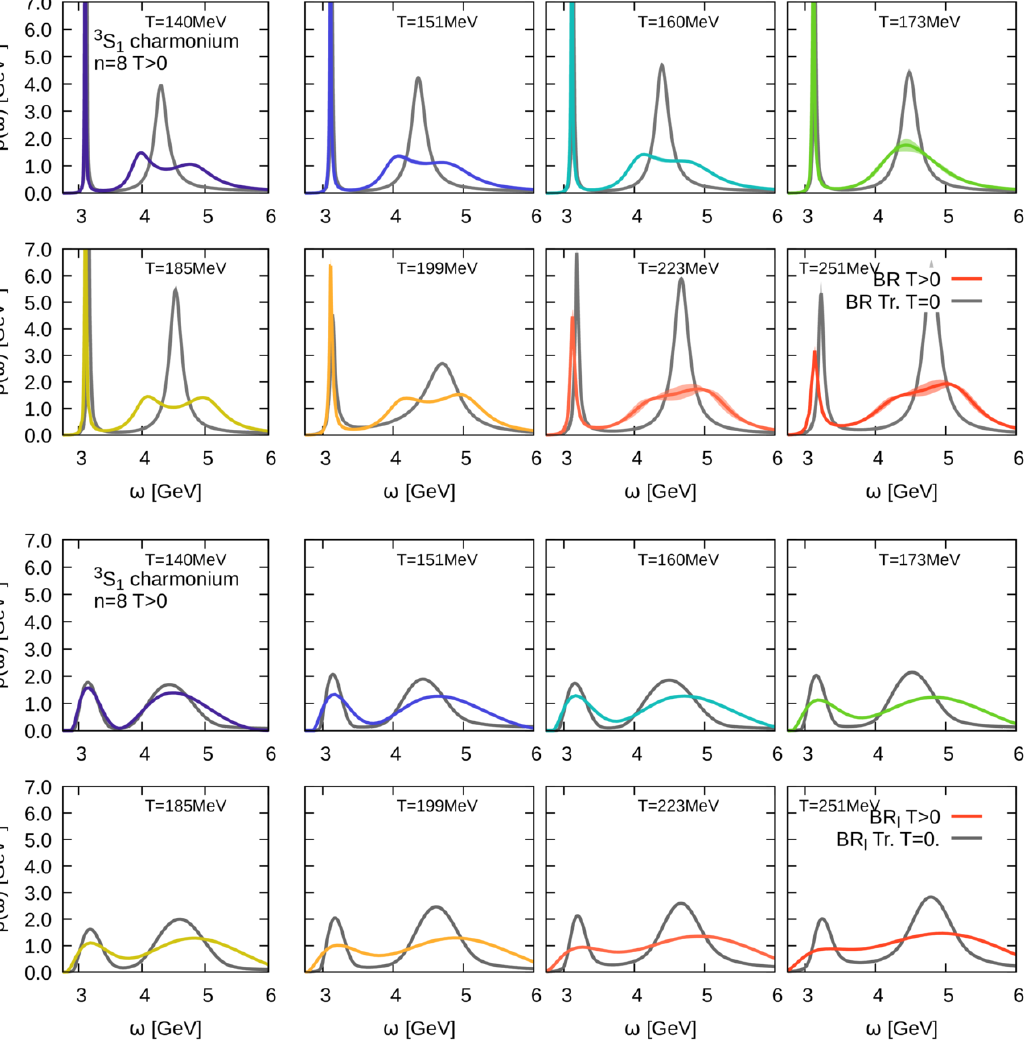
Figure 42 . Comparison of the (top) BR truncated at T = 0 and at T > 0 (bottom) the same comparison for the smooth BR method in the 3 S 1 charmonium channel. Here we have the same statistics at T = 0 and at T > 0.